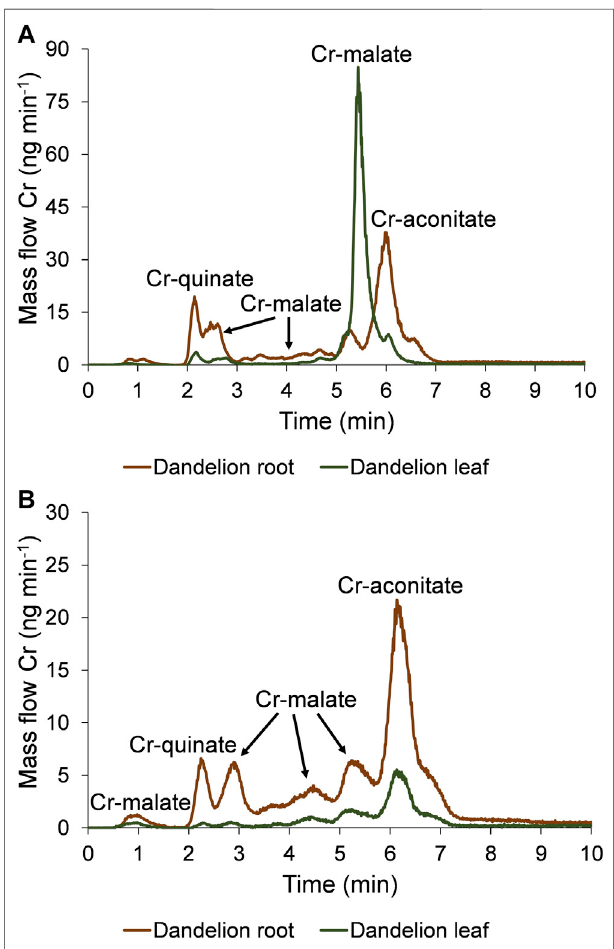
FIGURE 5 | Speciation of Cr in fi ve-times diluted dandelion root and leaf sap by HPLC-ICP-MS. Cr mass fl ow is based on measurements of isotope ratios m/ z 50 and 52. Dandelion was grown in soil with a low Cr content (55.9 ±1.2 mg kg − 1 ),and wasexposedfor48 h tosyntheticsolutionsof (A) Cr(VI) and (B) Cr-nitrate (pH 6.5, 5000 ng ml − 1